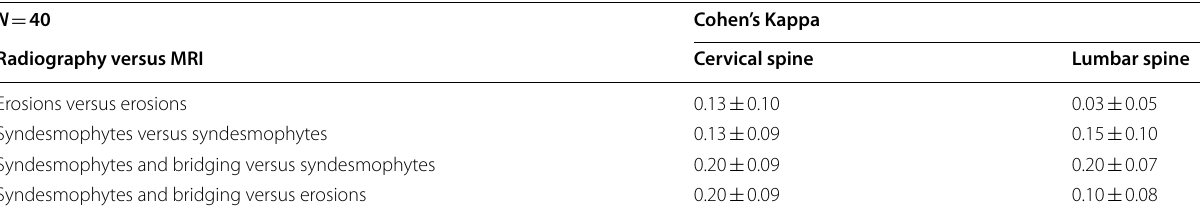
Table 2 Agreement between radiographic and MRI findings for erosions and syndesmophytes/bridging in the cervical and lumbar